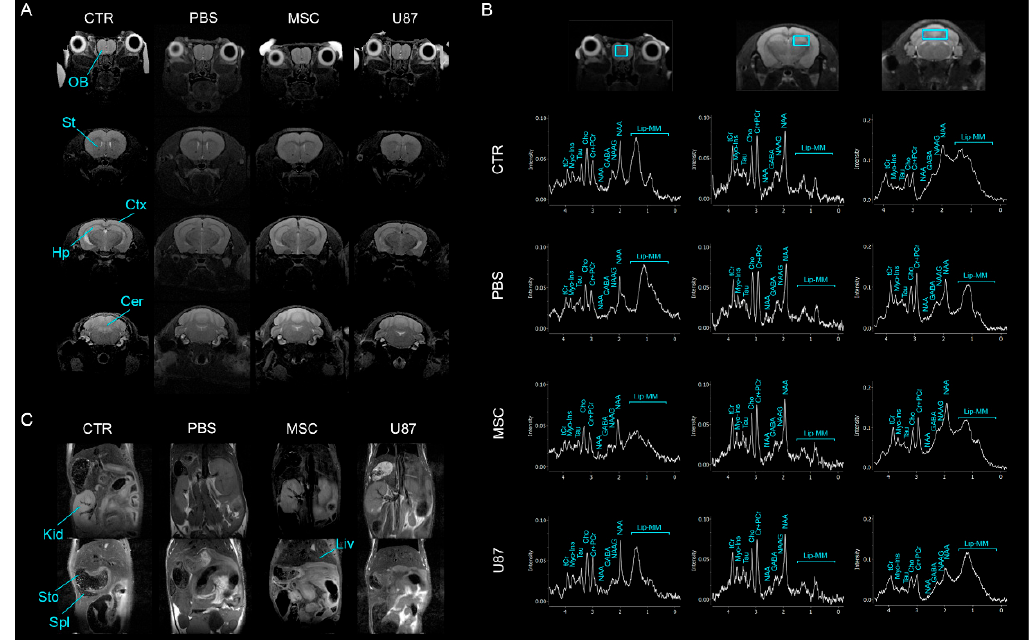
Figure 4. Intranasal administration of MSCs does not induce anomalies in the brain and other main organs in vivo. ( A ) Axial MRI sequence of the brain of a representative MSC animal at the long-term. ( B ) 1 H-MRS in the olfactory bulb, hippocampus and cerebellum of mice at the long-term. ( C ) Coronal MRI sequence of the abdomen of a representative MSC animal at the long-term. Cr, creatine; Cer, cerebellum; Cho, choline; Ctx, cortex; GABA, g-aminobutyric acid; Hp, hippocampus; Kid, kidney; Lip, Lipid; Liv, liver; MM, macromolecules; Myo-Ins, Myo-inositol; NAA, N-acetylaspartate; NAAG, N-acetylaspartatylglutamate; OB, olfactory bulb; PCr, phosphocreatine; Spl, spleen; St, striatum; Sto, stomach; Tau, taurine; tCr, total creatine. n = 3–4 per group.